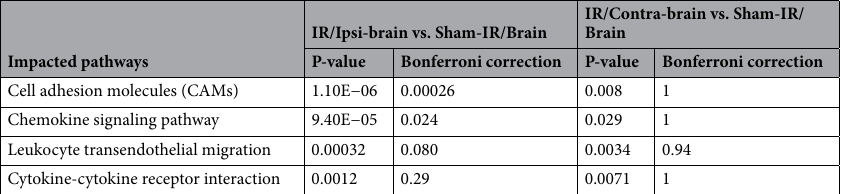
Table 1. The list of the significantly impacted pathways in IR/Ipsi-brain and IR/Contra-brain groups, as compared to the control group (Sham-IR/Brain). Bonferroni; corrected P-values by the Bonferroni method for multiple comparisons.